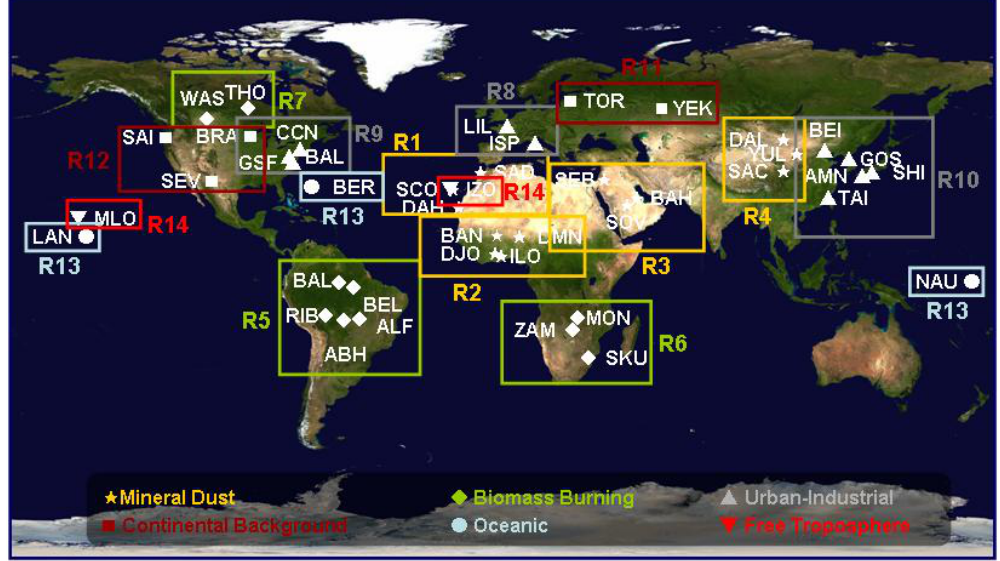
Fig. 1. Geographical distribution of the AERONET stations used. These stations were grouped into 14 regions, according to key aerosol types and their geographic location. Each aerosol type is labeled with a different symbol: mineral dust as stars, biomass burning as diamonds, urban-industrial as triangles, background continental as squares, oceanic as dots and free troposphere as inverted